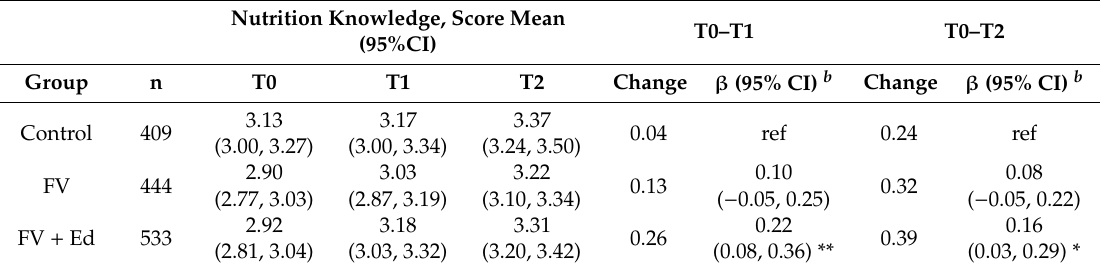
Table 4. Short- and long-term intervention e ff ects on children’s nutrition knowledge for the total sample ( n = 1386) a .